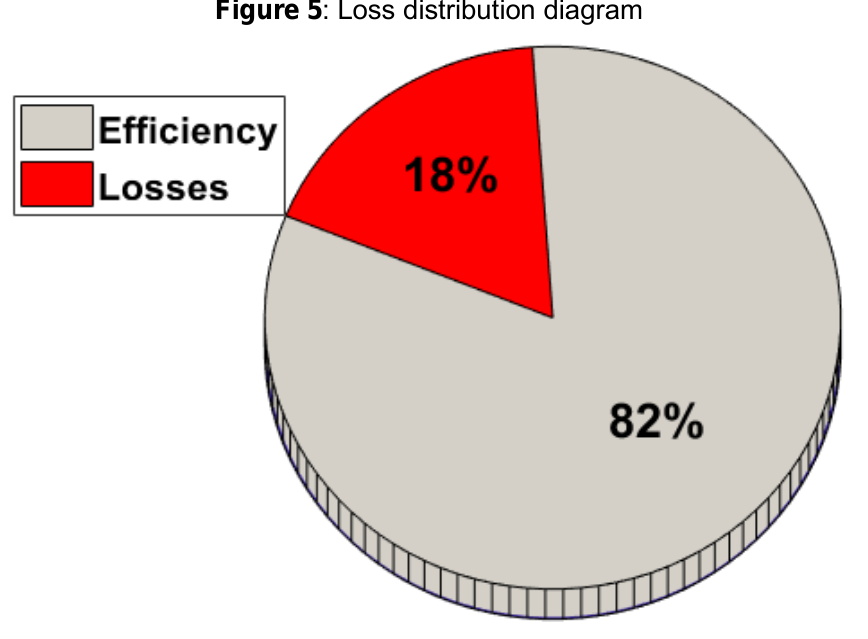
Figure 6 : Total loss